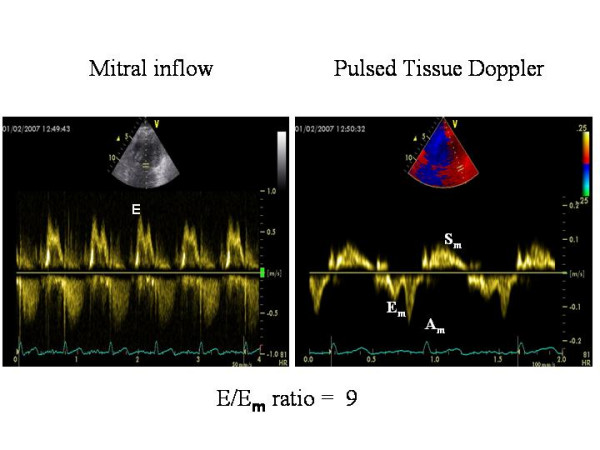
Standard Doppler derived transmitral inflow pattern (left panel) and Pulsed Tissue Doppler of the lateral mitral annulus in a HT recipient. The ratio is = .9.